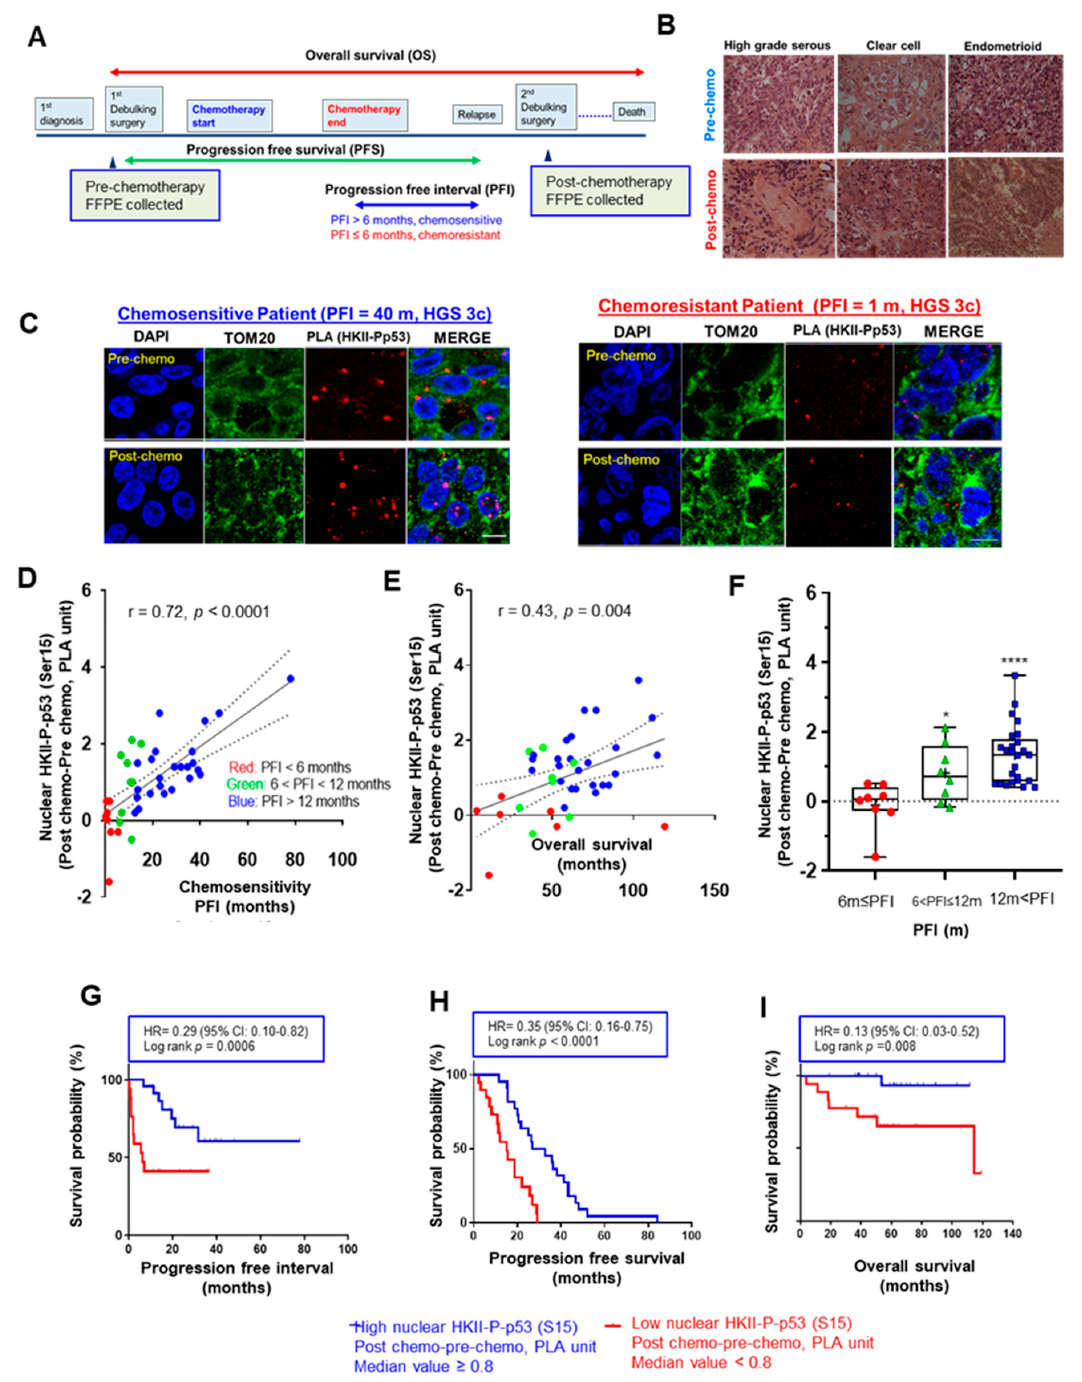
Figure 1. Chemotherapy-induced nuclear interaction of HKII-P-p53 (Ser15) in tumor tissue sections is associated with chemoresponsiveness in OVCA patients. ( A ) Paired pre- and post-chemotherapy high-grade serous ovarian tumor sections from the same patients ( n = 41, total 82 sections) were collected at primary and secondary cytoreductive surgery, respectively. Samples were formalin-fixed and paraffin-embedded. Sections were stained with HKII and P-p53 (Ser15) antibodies. Lengths of progression-free survival (PFS, from cytoreductive surgery to recurrence of cancer), progression-free interval (PFI, from the end of first chemotherapy to recurrence of cancer), and overall survival (OS, from starting from cytoreductive surgery to death or last follow up) were calculated as pictured in the diagram. ( B ) Representative images of hematoxylin–eosin- stained sections of different histological subtypes of human EOC; scale bar: 10 µ m. ( C ) In clinical ovarian cancer sections, the level of HKII-P-p53 (Ser15) interaction (proximity ligation assay (PLA) unit: red spot) and its cellular localization (blue: DAPI;